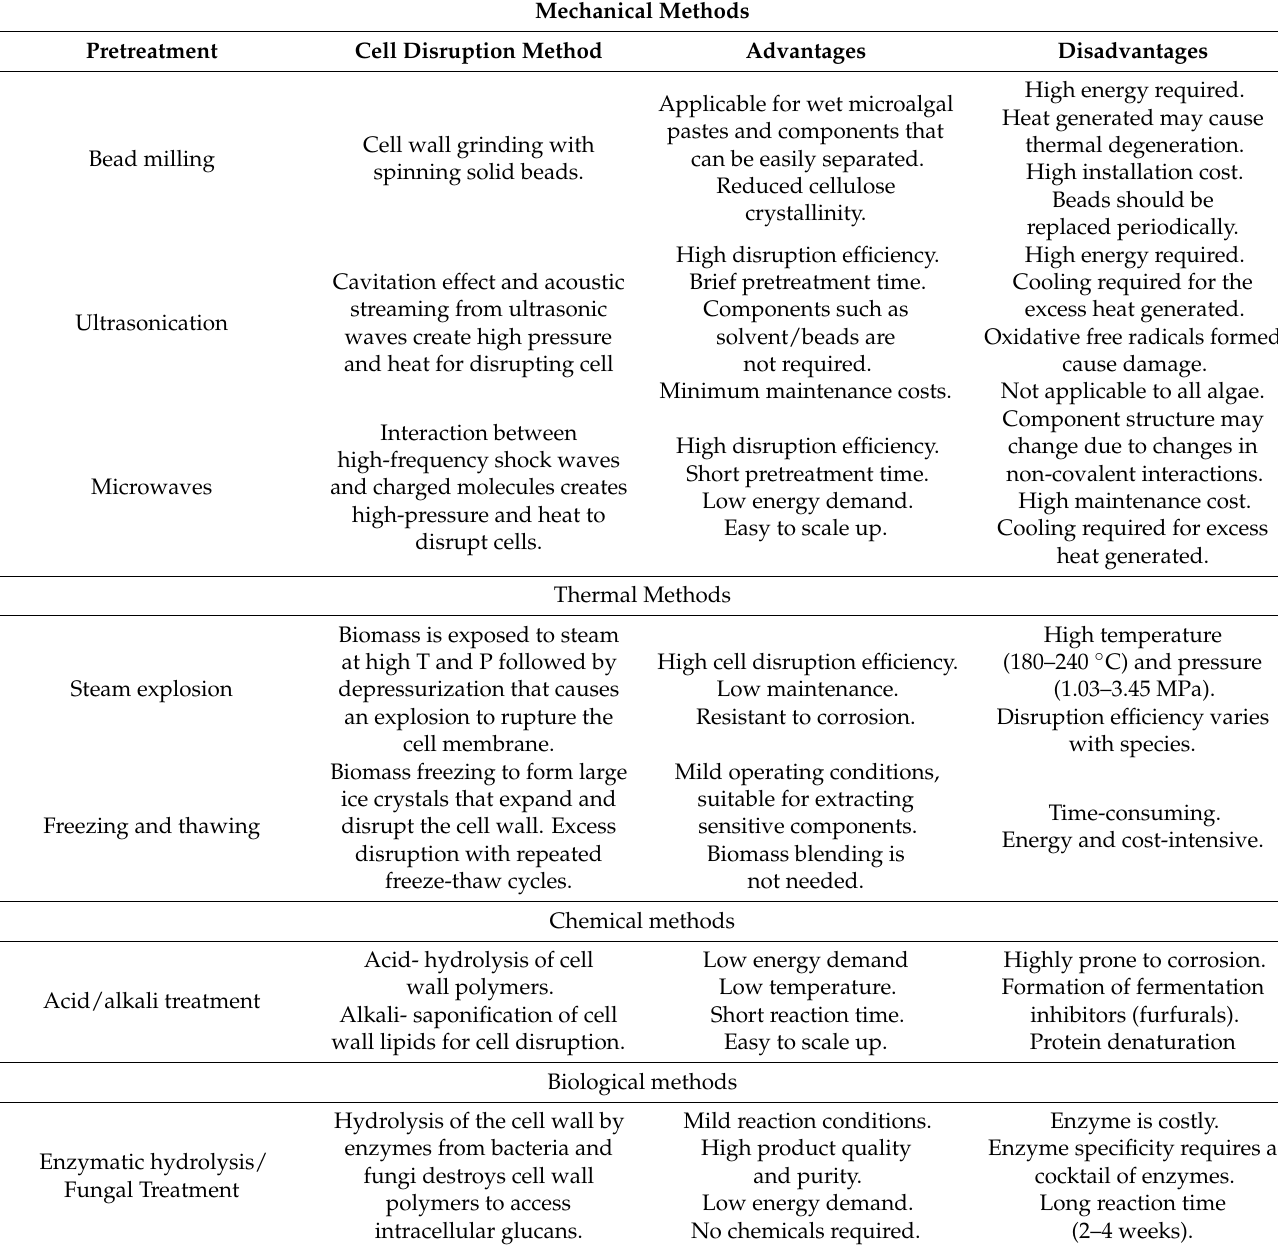
Table 3. Pretreatment methods and their advantages and disadvantages